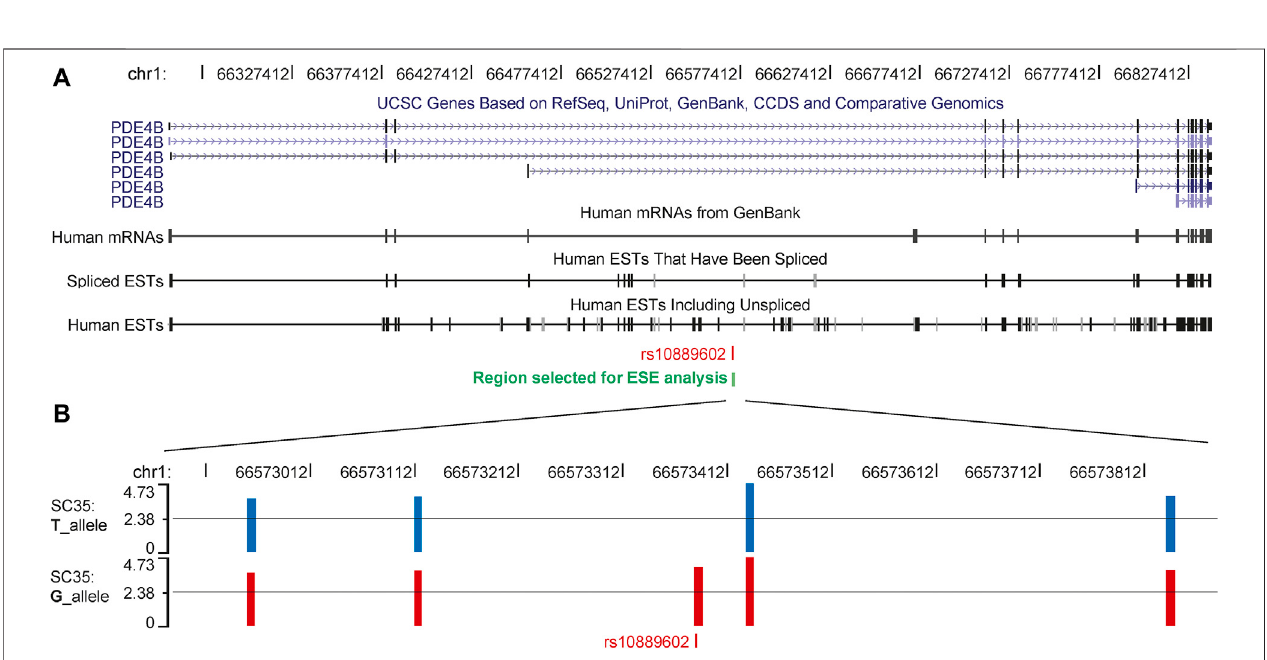
FIGURE3| Splicingproductsof PDE4B, theGallele ofrs10889602T/GgeneratesanewSC35bindingsite inthethirdintron. (A) Sixisoformsandvarious typesof expressed sequence tags of PDE4B have been reported in the database of the University of California at Santa Cruz Genome Browser. (B) In a 1,000 bp region encompassing rs10889602T/G, ESE fi nder predicted either 4 or 5 binding sites for the splicing factor, SC35, with likelihood scores greater than 3.500 for each chromosome. For the chromosome bearing the T allele, from left to right, the scores of the SC35 binding sites were 3.64, 3.80, 4.73, and 3.82, respectively. An extrabindingsitewiththelikelihoodscoreof4.001waspredictedinthesequencecontainingtheriskalleleguanosine (B) .ThesuggestedthresholdoftheESE fi nderwas 2.383 as shown by the black lines in each plot. ESE fi nder, Exon Splicing Enhancer Finder; SC35, serine and arginine rich splicing factor